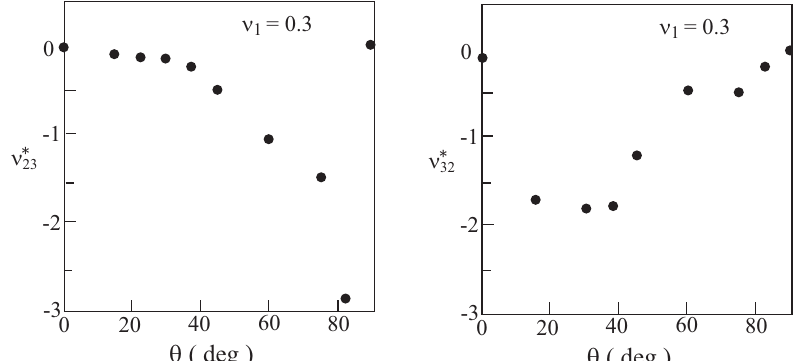
Figure 3. Variation of the effective Poisson ratios ν ∗ = 0 . 28 ). voids ( v f